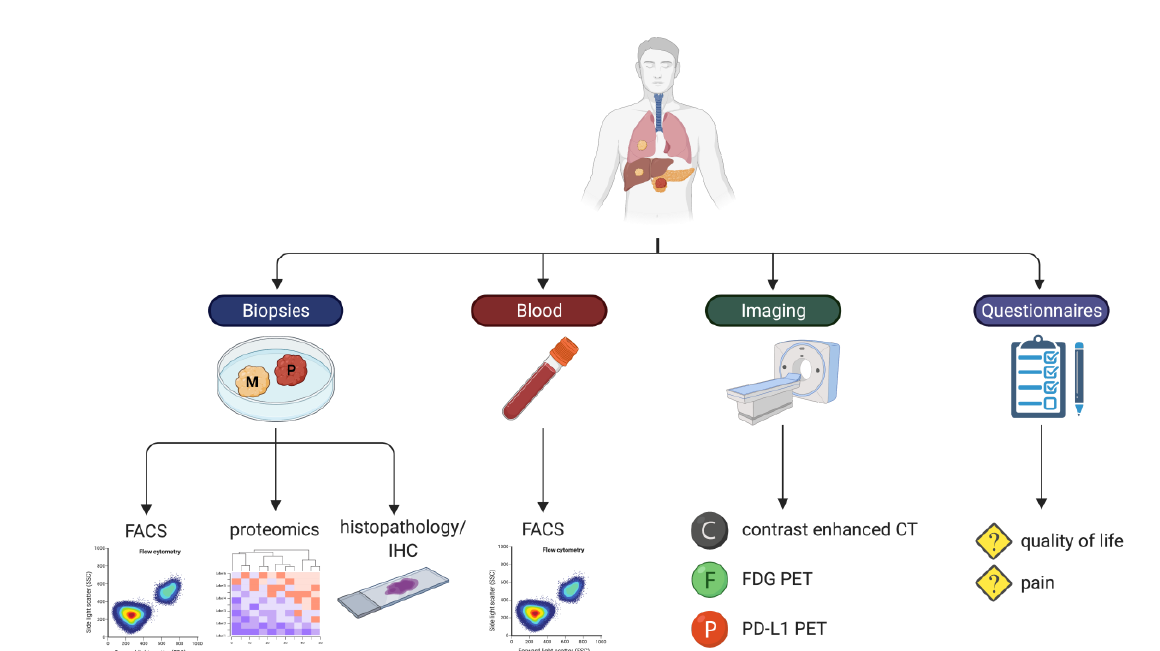
Figure 4. Data collection and analyses per patient in PANFIRE-III. Biopsies from primary (P) and metastatic (M) tissue will be analyzed using flow cytometry, histopathology/immunohistochemistry (IHC), and proteomics. Blood samples will be analyzed using flow cytometry. Imaging will be performed by ceCT, FDG ( 18 F-FDG) PET-CT, and PD-L1 ( 18 F-BMS-986192) PET-CT. Pain scores and quality of life scores will be evaluated by validated